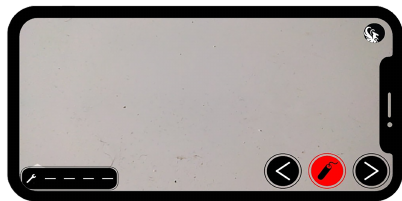
Figure 3. Main maintenance interface that includes the layout of the buttons and the progress